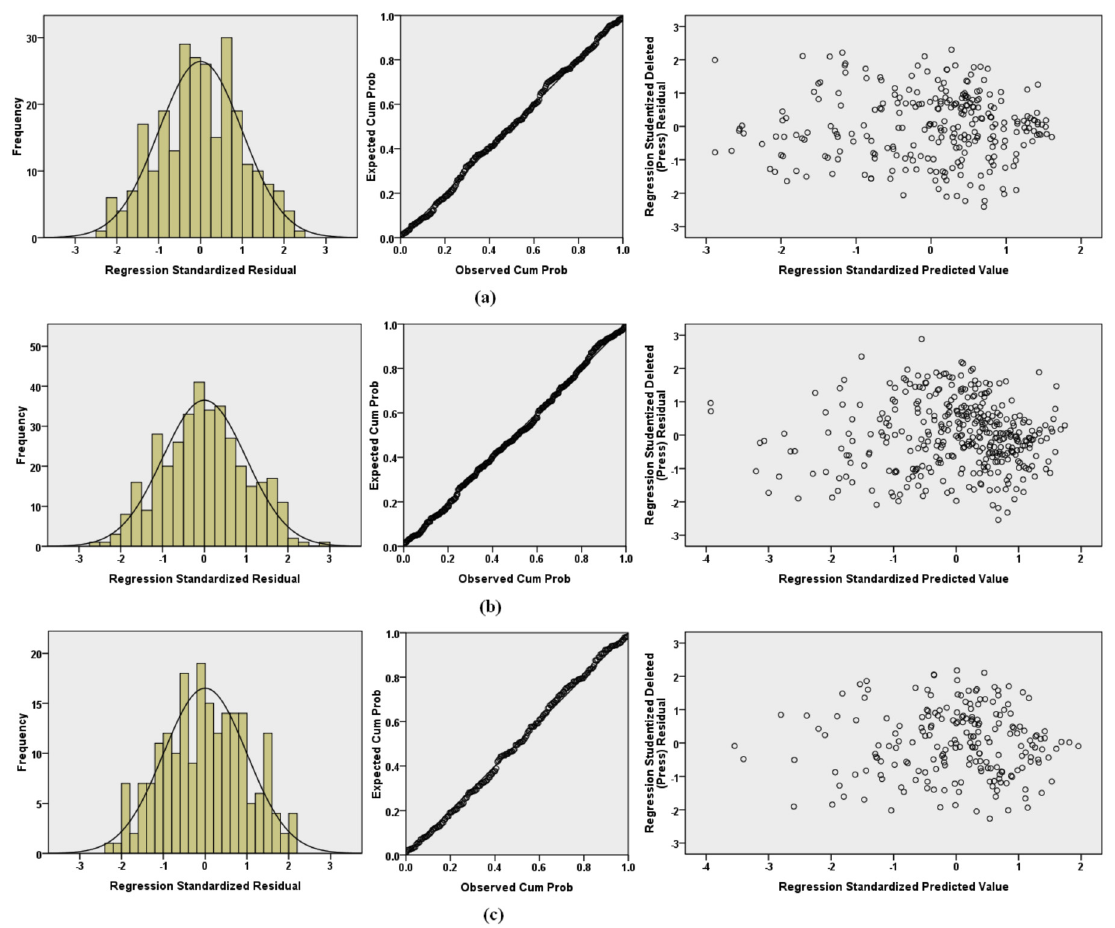
Figure 7. histogram of the residual, probability-probability (p-p) plot of regression standardized residual and studentized residual plot for (a) fine grain soil, (b) sandy soils and (c) gravely